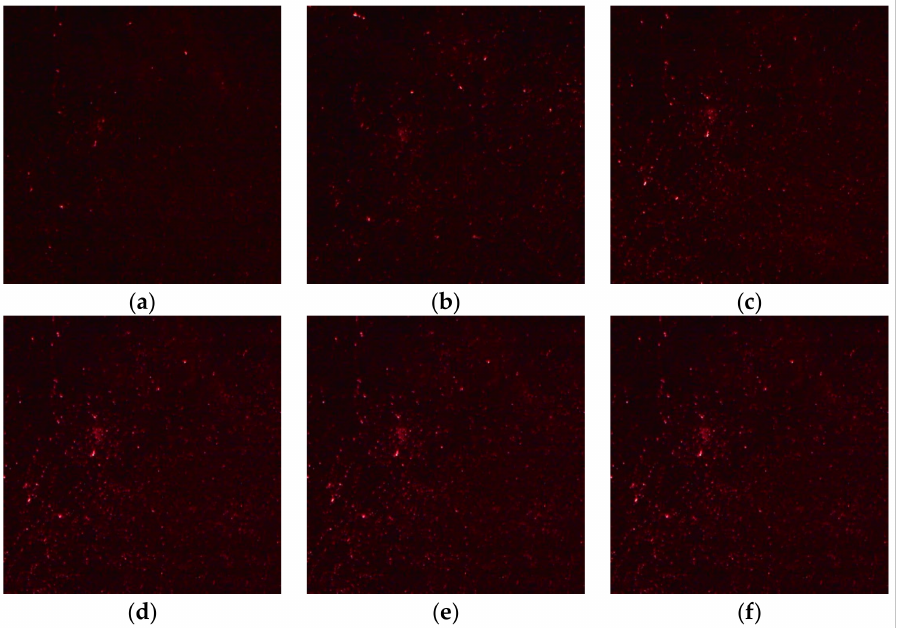
Figure 12. Reflected images of PSi microcavities at di ff erent incident angles: ( a ) 0 ◦ ; ( b ) 1 ◦ ; ( c ) 2 ◦ ; ( d ) 3 ◦ ; ( e ) 4 ◦ ; ( f ) 5 ◦ .